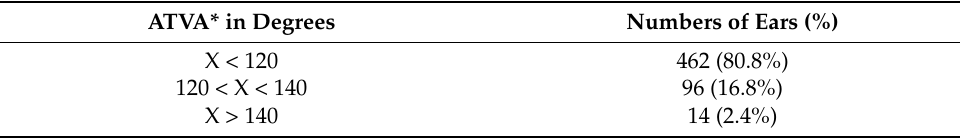
Table 2. ATVA* categorized by Bächinger